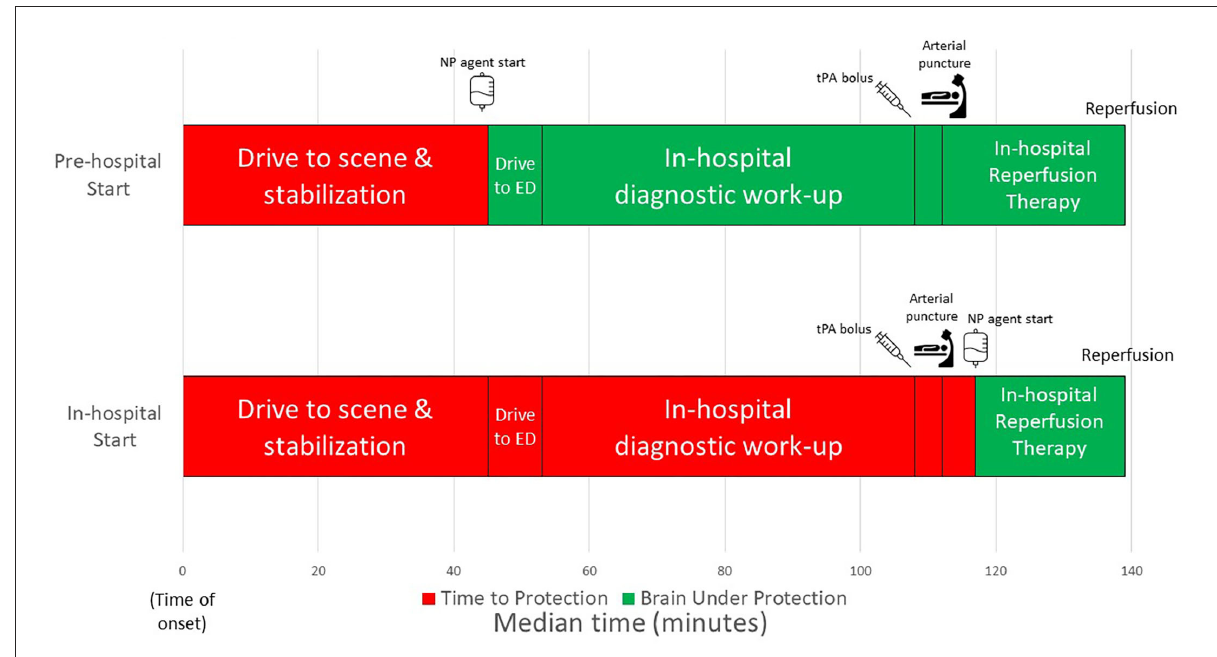
FIGURE1 Workflow times comparing neuroprotective start strategies of in-hospital from ESCAPE-NA1 and pre-hospital from